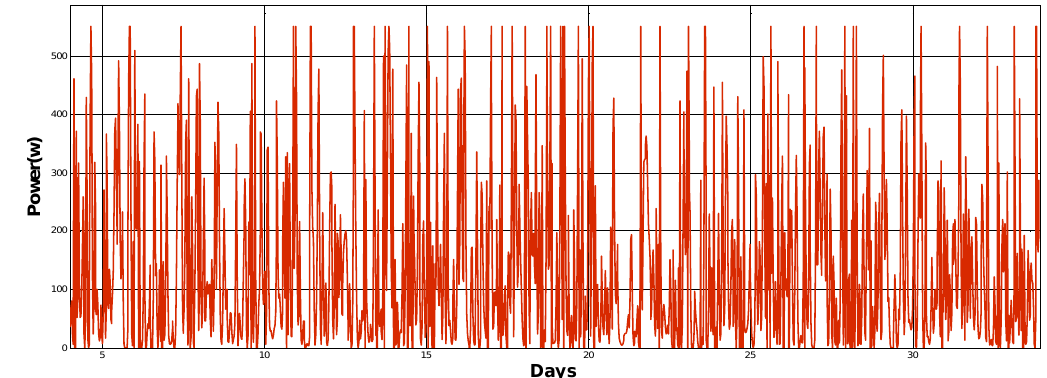
Figure 6. Power of wind turbines (w).